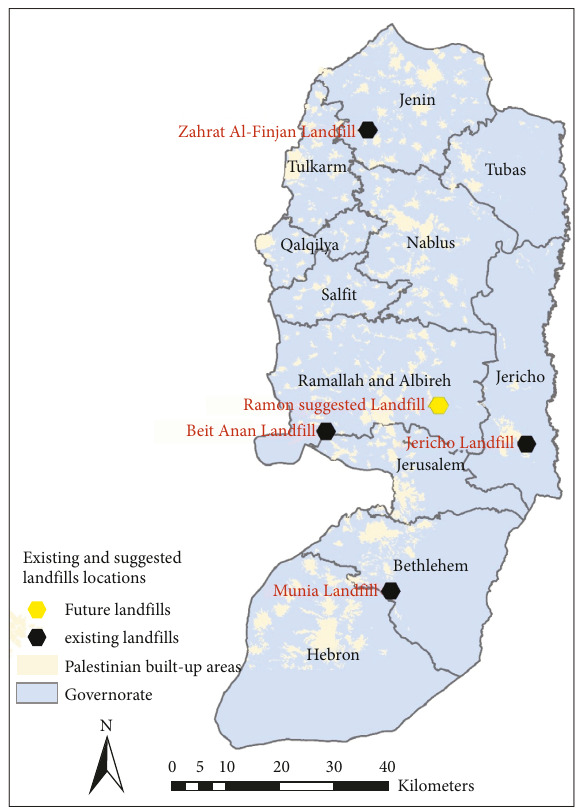
Figure 1: Existing and suggested landfills in the West Bank,